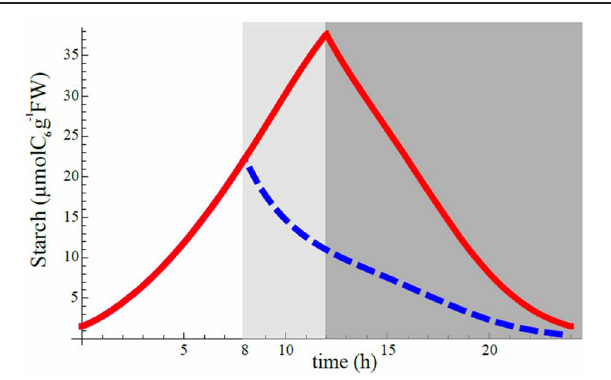
FIGURE 6 | Starch degradation profile after a sudden shortening of the light period. Red curve is obtained after minimization of starvation cost and corresponds to the optimal set of phase shifts for 12hL/12hD cycle (same as Figure 3C for 12hL/12hD cycle). Suddenly shortening the light period to a L/D cycle of 8h/16h (extending night period from the dark gray area to the light gray area) while still keeping the optimal phase shift set for 12hL/12hD cycle condition gives the blue dashed curve for the first day of the change. Vertical axis scale is perfectly consistent with Figure 1A of Graf et al. (2010) when converting their scale by taking 1mg of C 6 to be equal to 5.85 μ